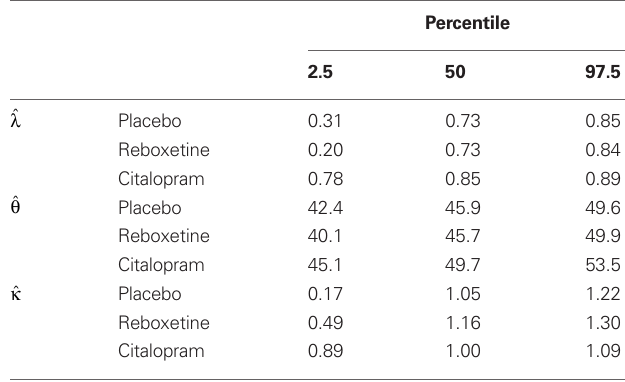
Table S2 | The 2.5, 50 and 97.5 percentile of the bootstrap sampling distributions of the ˆ,ˆ, κ and parameters.